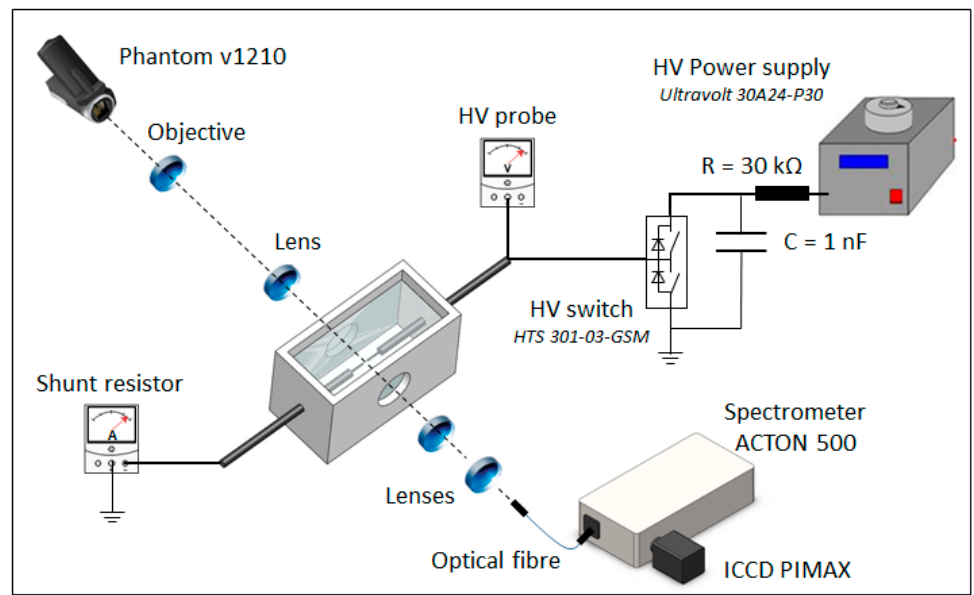
Figure 9. Experimental setup.